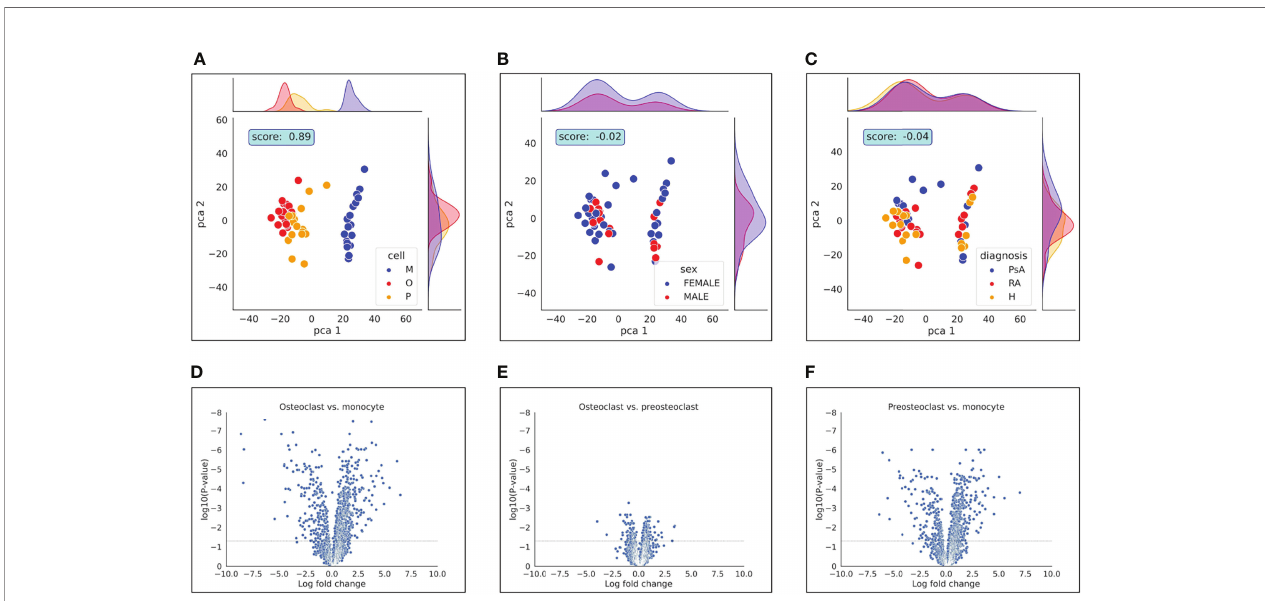
FIGURE 2 | PCA analysis and Volcano plot represent differences between samples. PCA analysis represents the differences between (A) : cell types, (B) : gender and (C) : diagnosis. Volcano plot represents the differences of (D) : osteoclast vs. monocyte, (E) : osteoclast vs. preosteoclast and (F) : preosteoclast vs. monocyte. Dashed horizontal line indicates adjusted p-value of